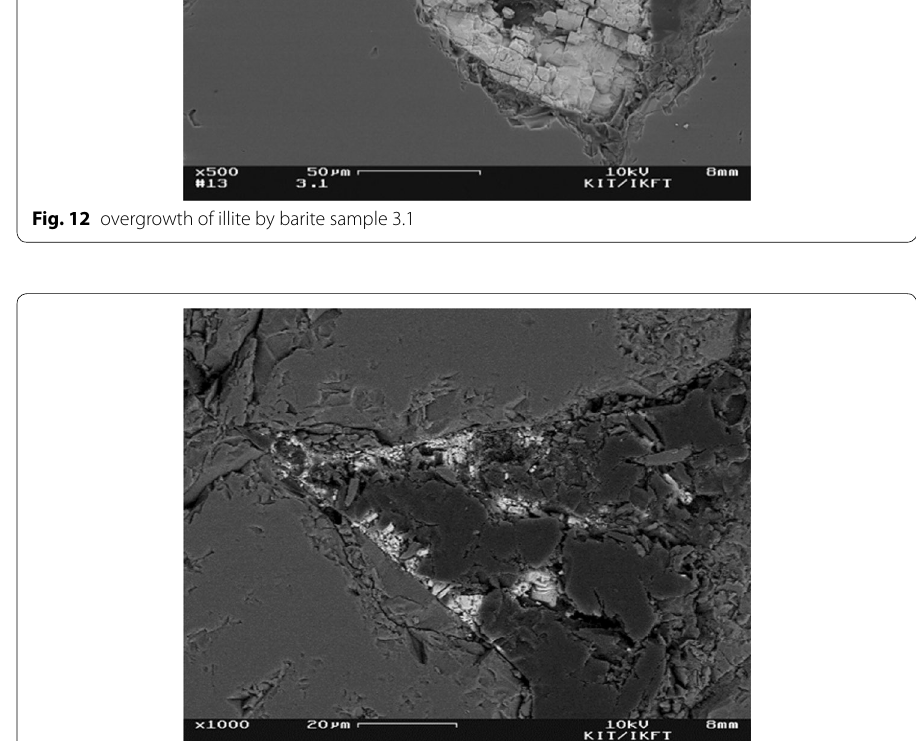
Fig. 13 Preferential accumulation of the barite crystals in the tips of the pore spaces, sample